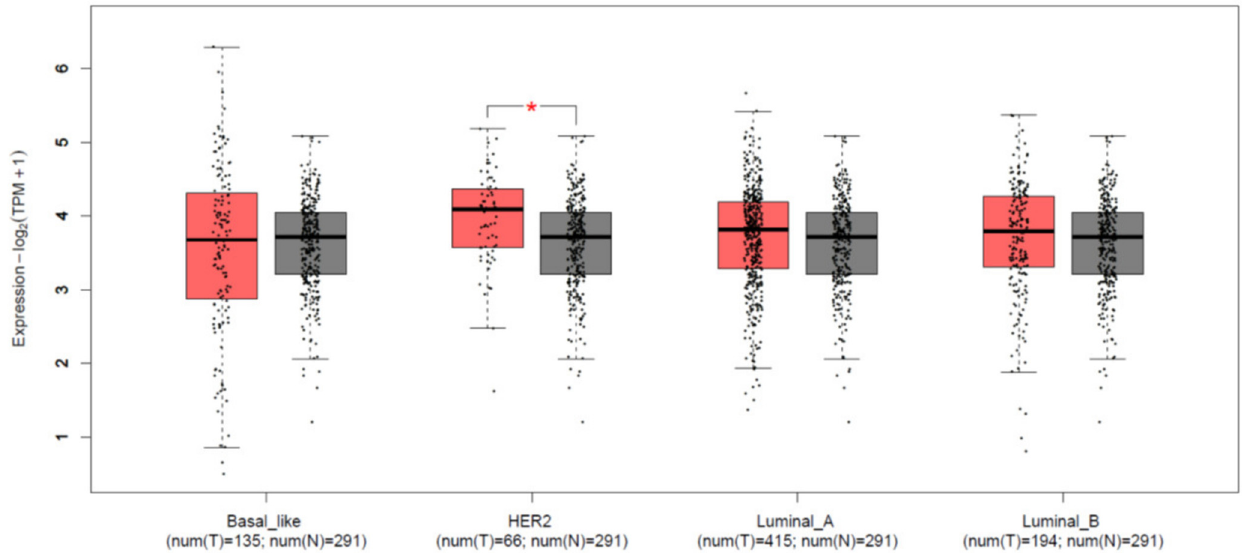
Figure 1. KCTD15 mRNA expression in breast cancer different subtypes and normal tissues (GEPIA). Box plots show median mRNA expression levels of KCTD15 in breast cancer tumors (red plots) and the corresponding normal tissues (gray plot). Axis units are Log2 (TPM + 1). * red = p -value < 0.01. T = tumor tissues. N = normal